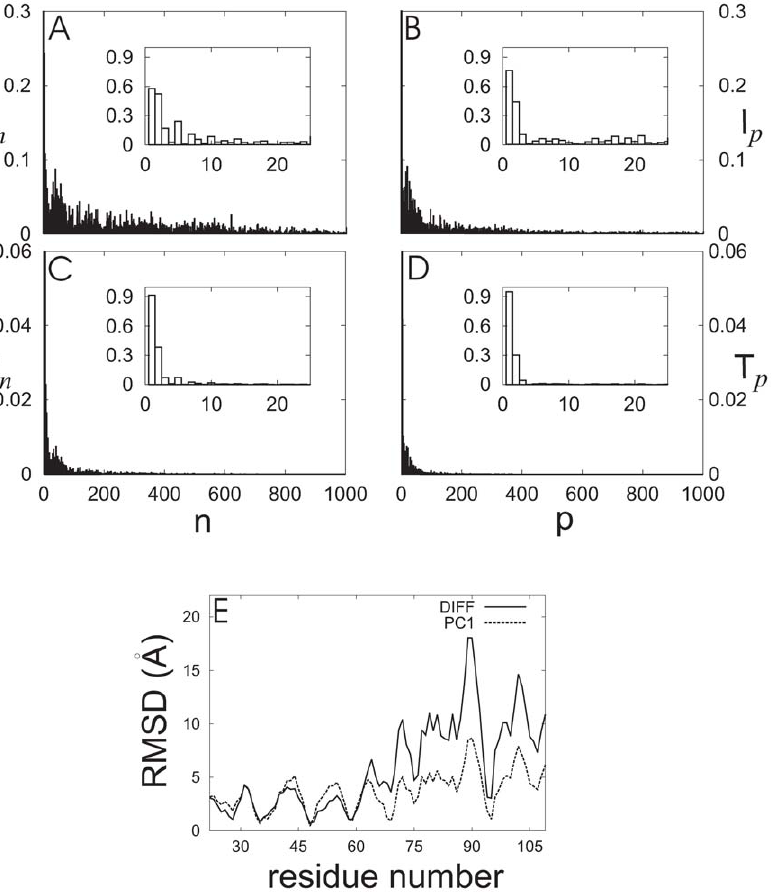
Figure 14. Influence of ligand binding on normal modes and principal components of PDC109. Involvement coefficients ( I n ) and thermal involvement coefficients ( T n ) in the space spanned by normal modes n are displayed in (A) and (B), respectively. The corresponding decompositions into the principal components are shown in (C) and (D). Insets show a magnified view for low mode frequencies. (E) Residue-wise comparison of amplitudes of PC1 eigenvectors at 0 o and 180 o (PC1, dashed line) and conformational difference (DIFF, solid line) between ligand-free and PhC-bound PDC109. At each residue, backbone atom coordinates were averaged out and the normalized difference between opposite components was scaled by a factor of 2.36 to obtain a best-fit conformational